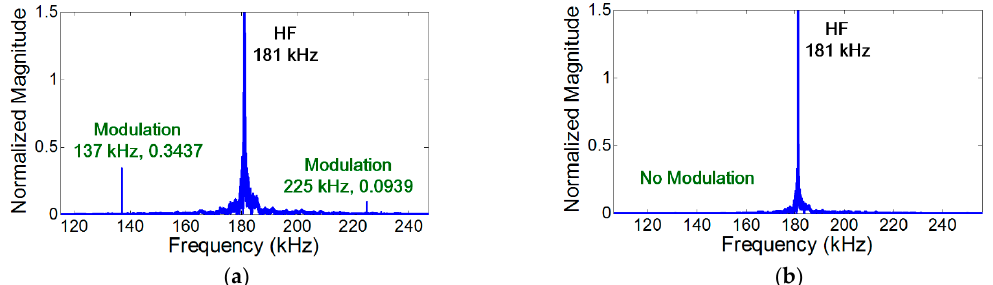
Figure 7. Experimental validation of the mode matching condition. The modulation does not occur when the modes of both LF and HF are A 0 . Here, the crack is located at the anti-nodes of both LF and HF vibration modes, and the synchronism condition is avoided to minimize the effect of distributed material nonlinearity. ( a ) LF (44 kHz) and HF (181 kHz) inputs generate S 0 and A 0 modes, respectively; ( b ) Both LF (50 kHz) and HF (181 kHz) inputs generate A 0 modes.